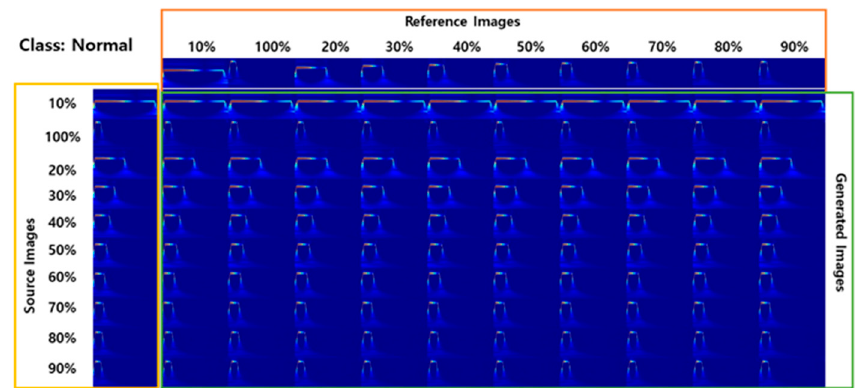
Figure 21. Generated images for the normal class with domain knowledge transfer.